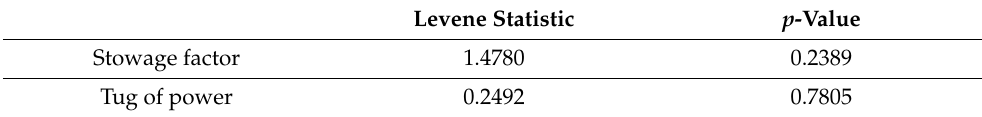
Table 10. Levene’s test.